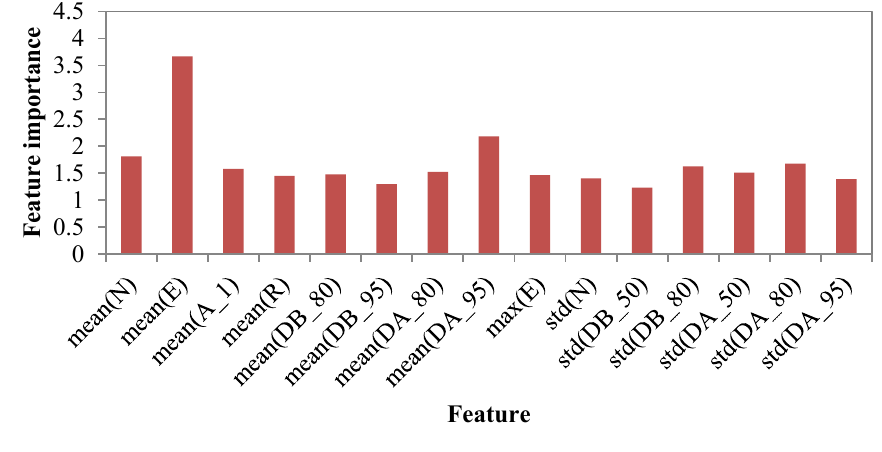
Figure 9. Feature importance for 15 most significant features selected from FWF features; the greater the value, the more important the